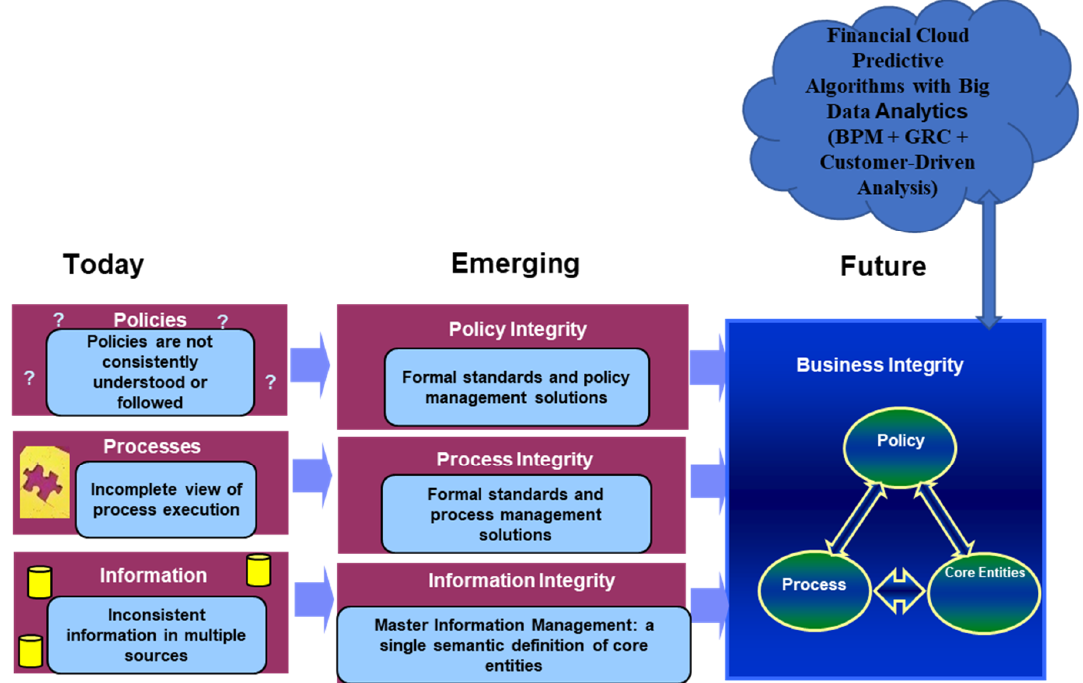
Figure 2. The evolution from managing individual integrity for policy, process, and information to manage.